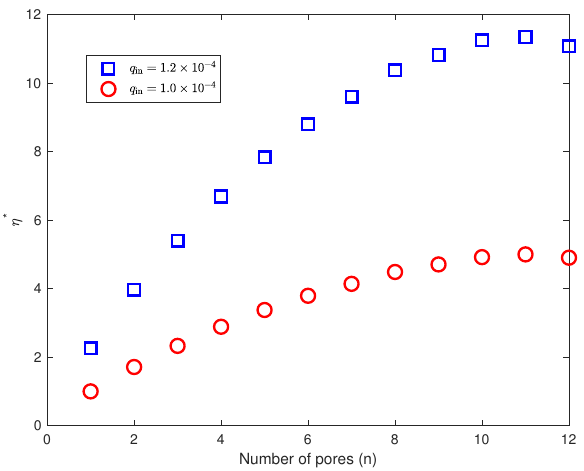
Figure 13. Overall efficiency of multiple pores obtained from TLBM simulation: blue squares represent the case of q in = 1.2 × 10 − 4 ; red circles represent the case of q in = 1 × 10 − 4 ; efficiency is normalized with respect to the case that T wall = 1 × 10 − 4 and n =